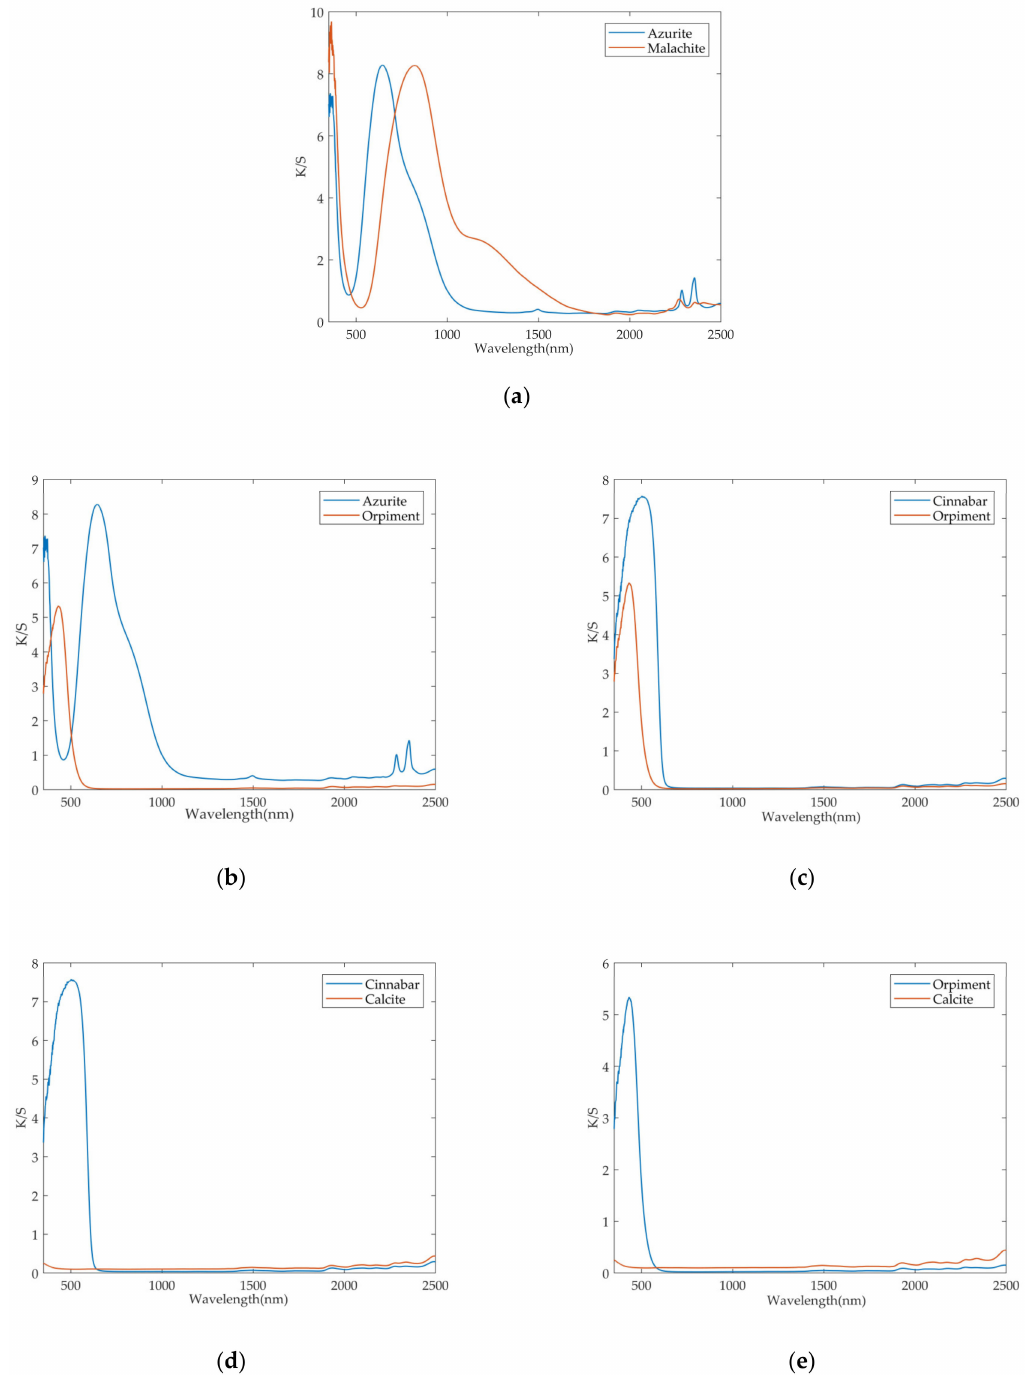
Figure 6. The ratio between the absorption and scattering coefficients of different mineral pigments: ( a ) azurite and malachite pigments; ( b ) azurite and orpiment pigments; ( c ) cinnabar and orpiment pigments; ( d ) cinnabar and calcite pigments; ( e ) orpiment and calcite